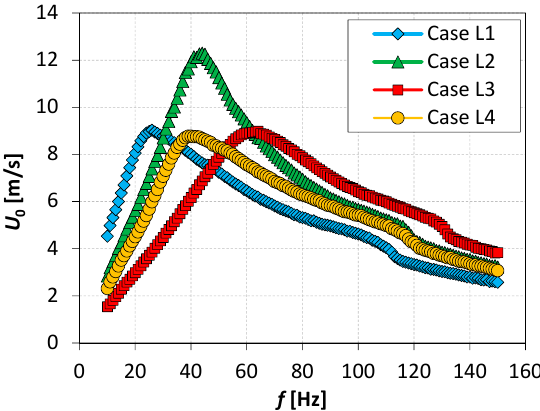
Figure 6. SJ jet centerline momentum velocity as a function of frequency, P = 4.0 W.